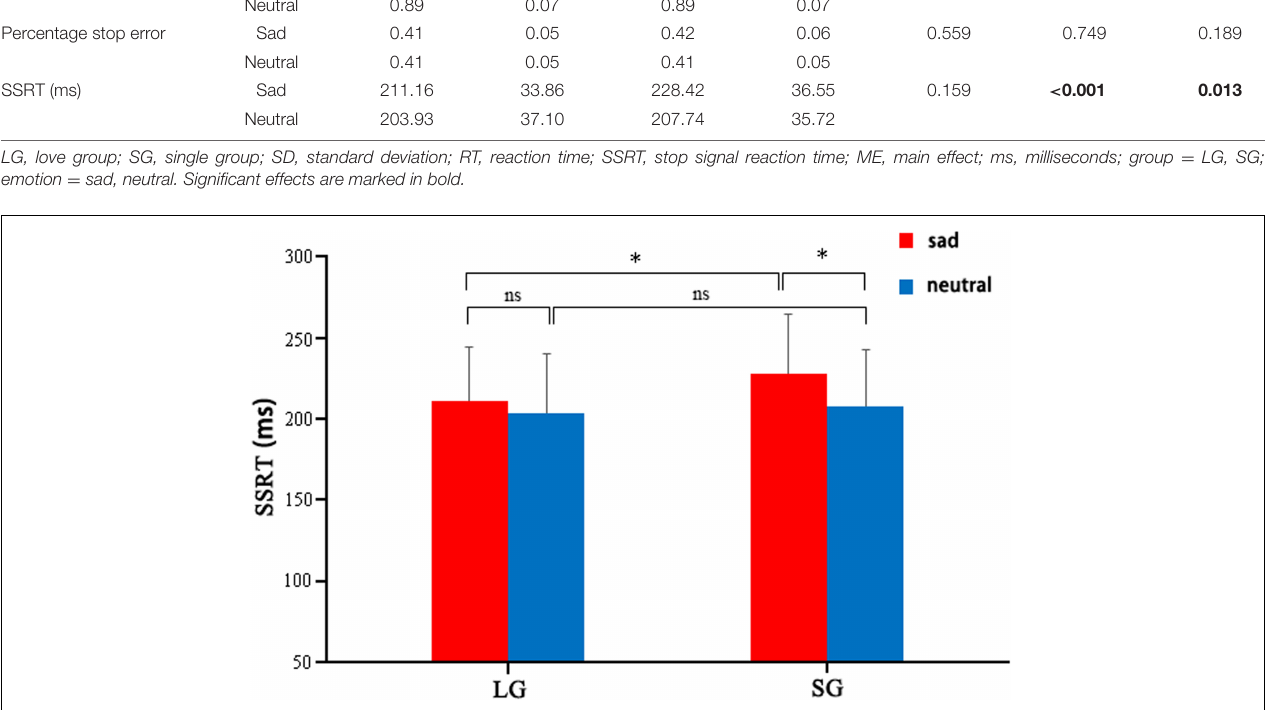
ME ( p ) (group) (emotion)